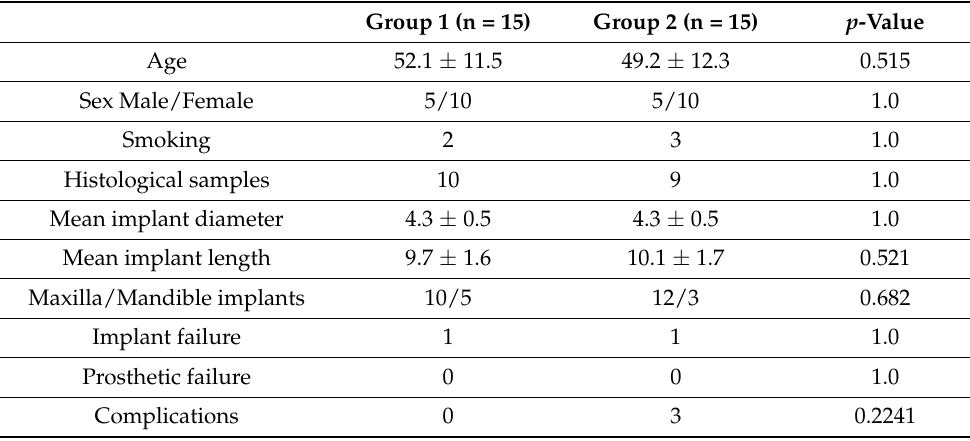
Table 1. Patient and implant characteristics between